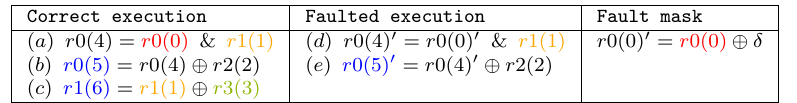
Table 3: DFA Equations generated for subgraph in Figure 4.4.